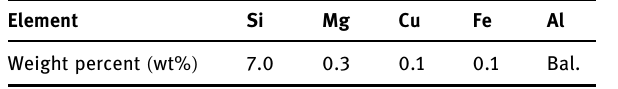
Table 1: The chemical compositions of the A356 alloy used